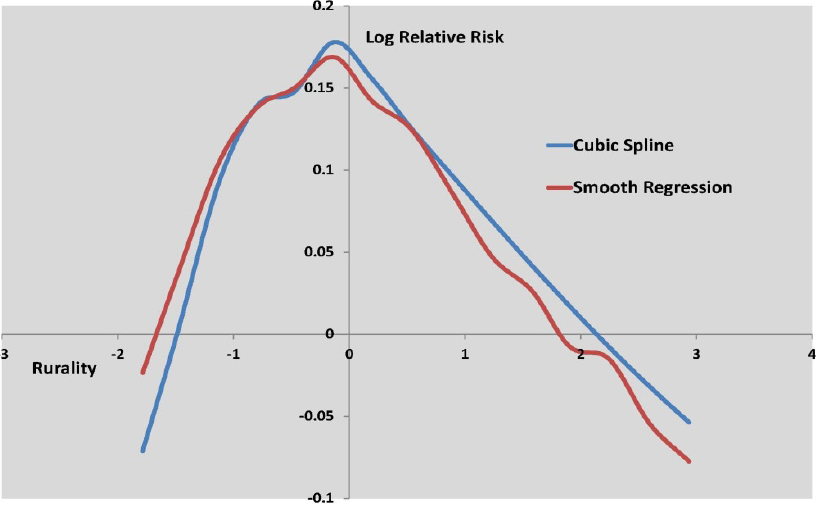
Figure 5. Log relative risk by rurality score, cubic spline and smooth regresssion.